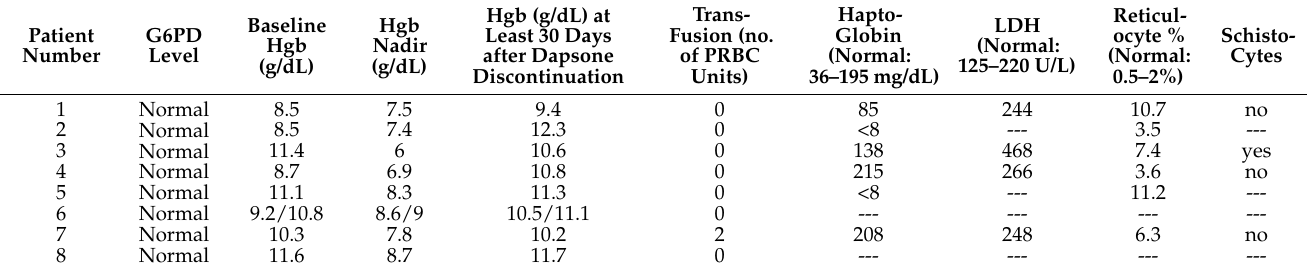
Table 2. Evidence of hemolysis.